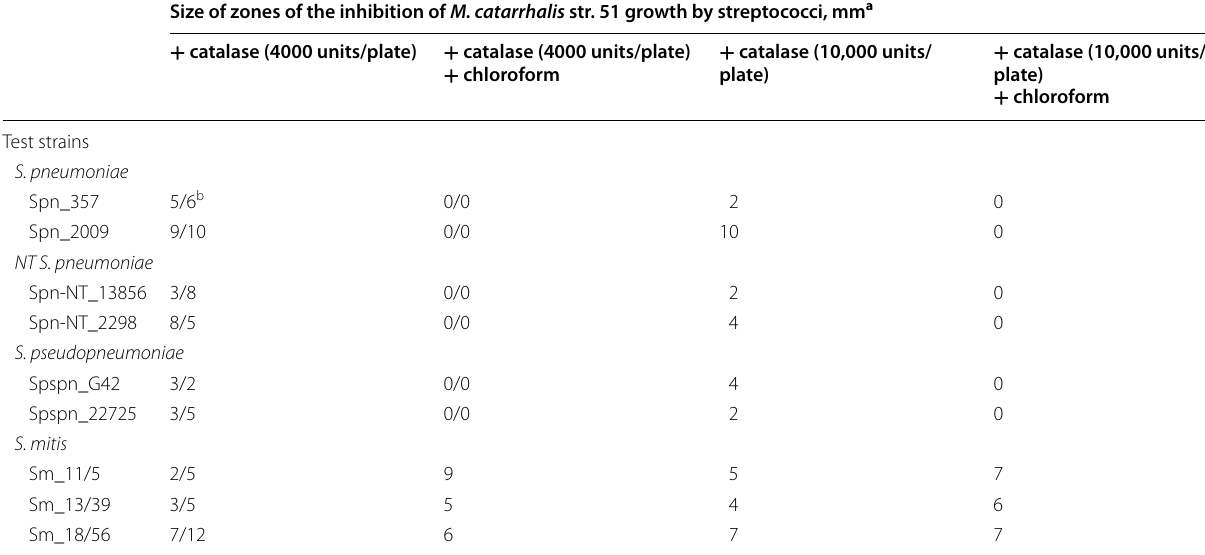
a In the cases when the bottom agar layer stabbed with the test strains was not treated with catalase, we have observed very extensive, often merging zones of M. catarrhalis strains growth inhibition, or no growth of the indicator strain at